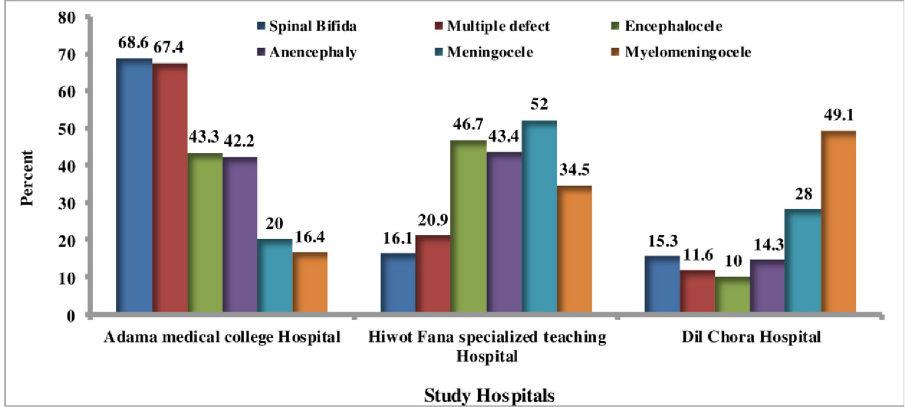
Fig 5. Percentage of different type of NTDs among study hospital, Eastern Ethiopia, data from